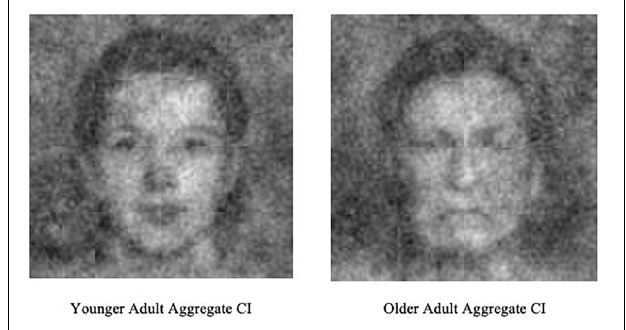
FIGURE 1 | Example classification images (CIs) produced across all participants for Study